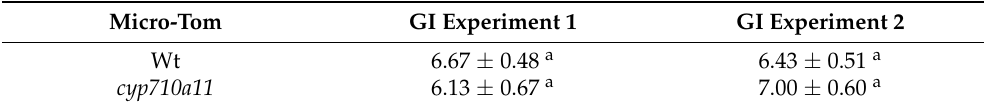
Table 3. Root gall index recorded after M. incognita infection of the cv. Micro-Tom wt and the cyp710a11 knockout mutant plants in two consecutive experiments.